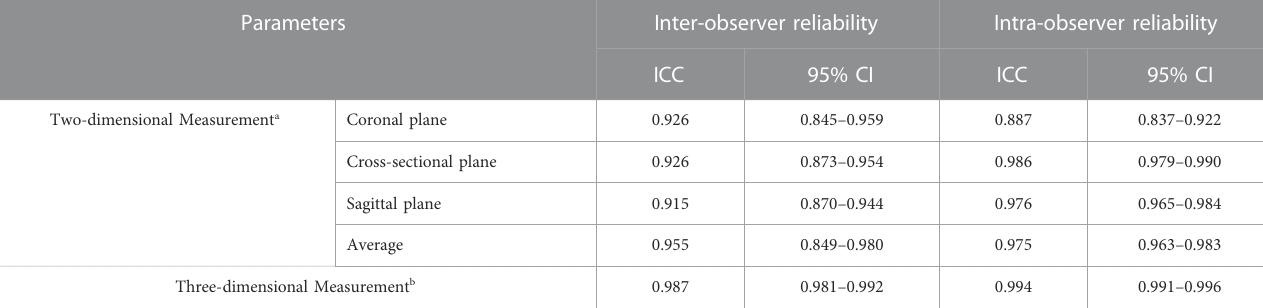
TABLE 2 Inter-observer and intra-observer